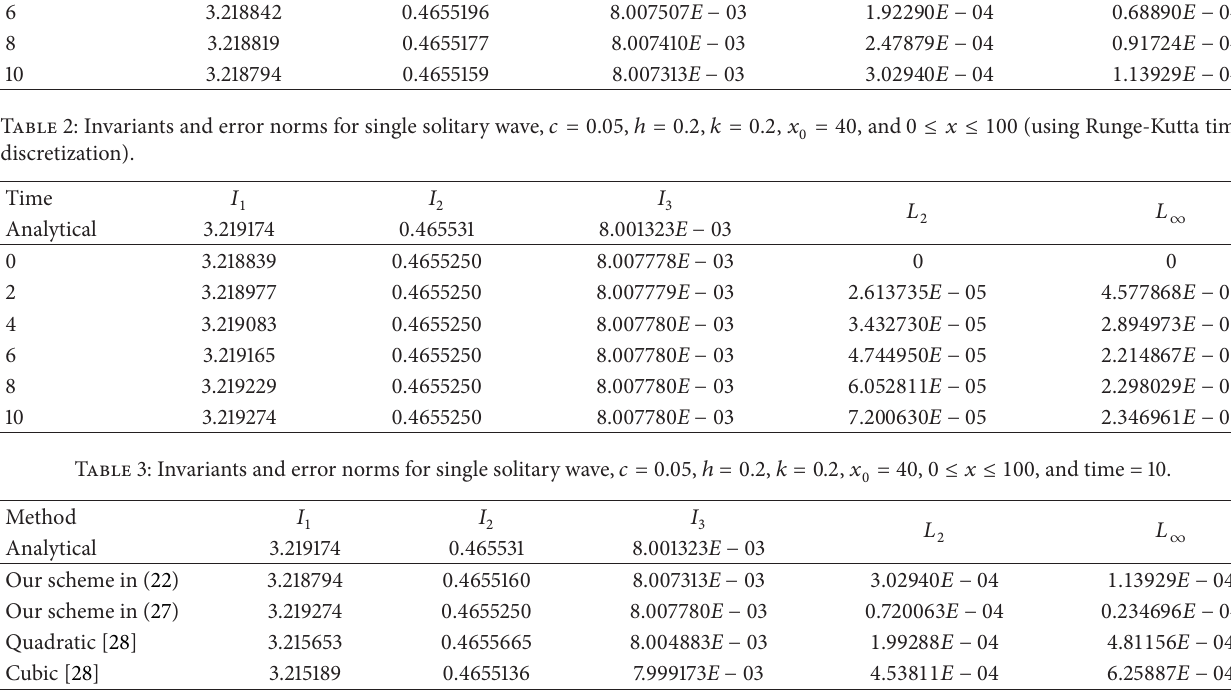
Our scheme in (27)